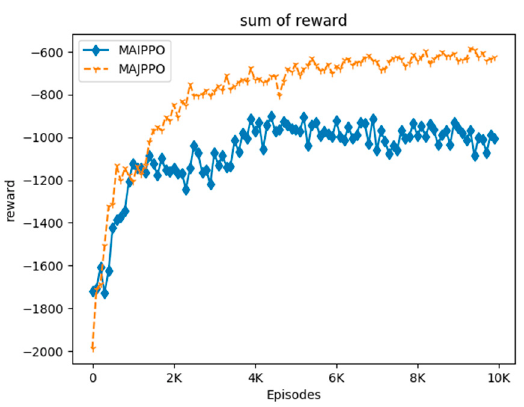
Figure 4. The curves of reward for multi-UAV formation uses the MAIPPO and the Multiagent Joint Proximal Policy Optimization (MAJPPO) for training.